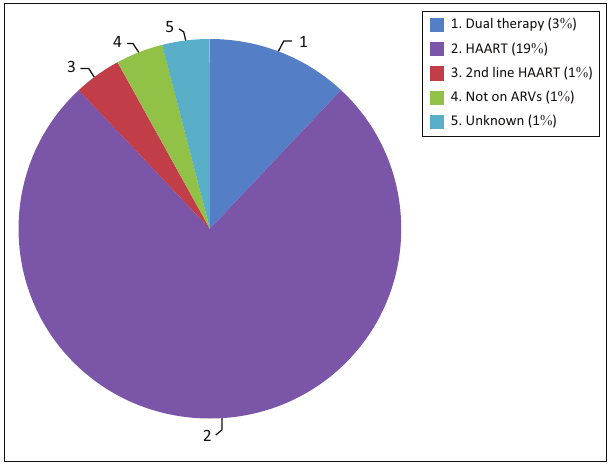
FIGURE 6: Antiretroviral (ARV) treatment of mothers who are HIV